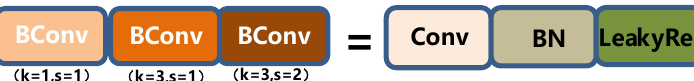
Figure 7. BConv structure layer diagram.